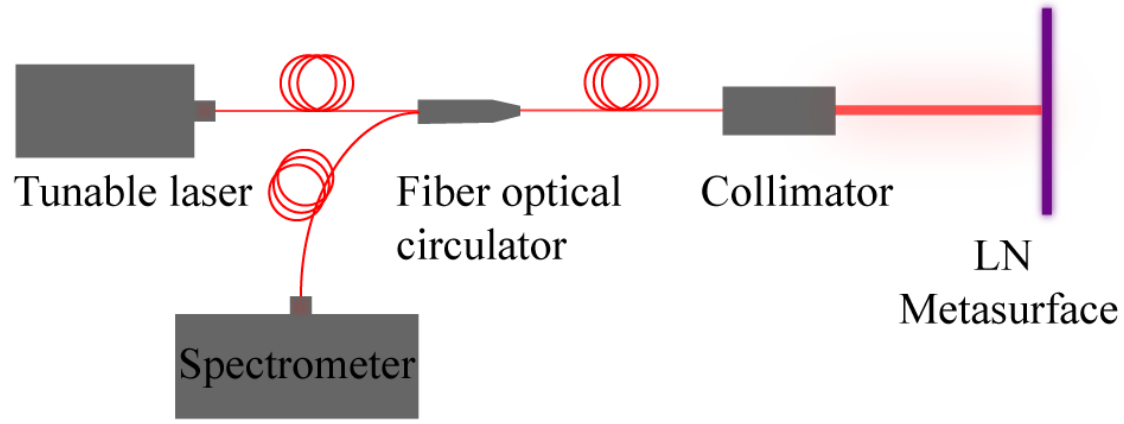
Figure 4. Reflectivity measurement optical path of LN metasurface.